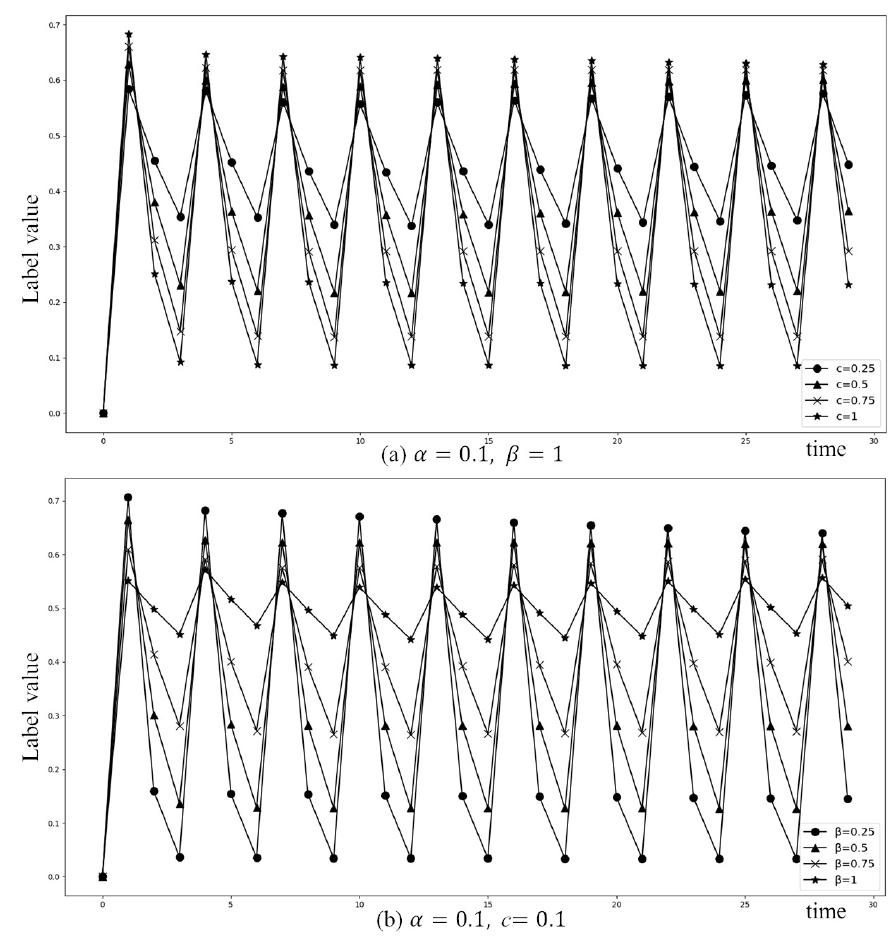
Figure 13. Fix β and c respectively, and calculate the first component of X 3 ( t ) . Two parameters are set to 0.25, 0.5, 0.75 and 1. Smaller c and larger β both have smaller peak value and larger valley